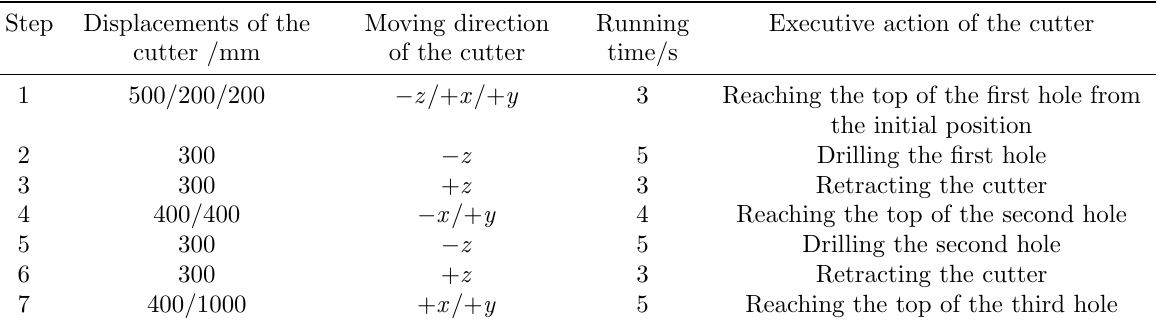
Table 6: The processing steps for drilling holes